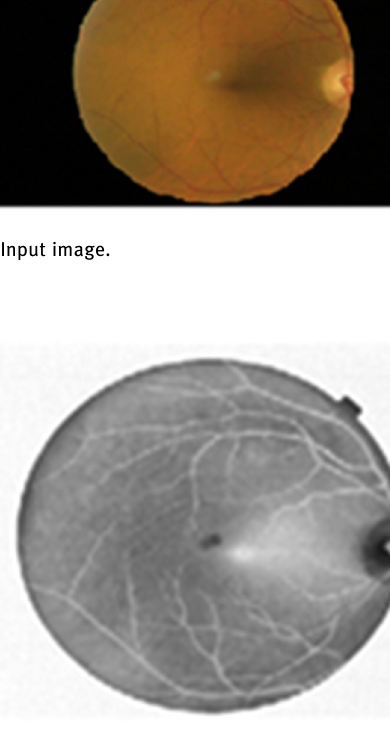
Figure 3: Blood vessel enhanced image using CLAHE.